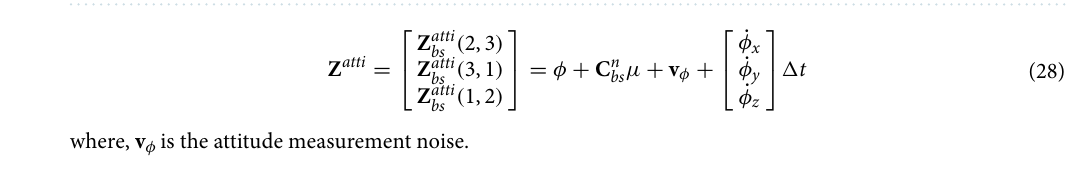
Figure 3. Comparison of state observability degree under 4 different maneuvering